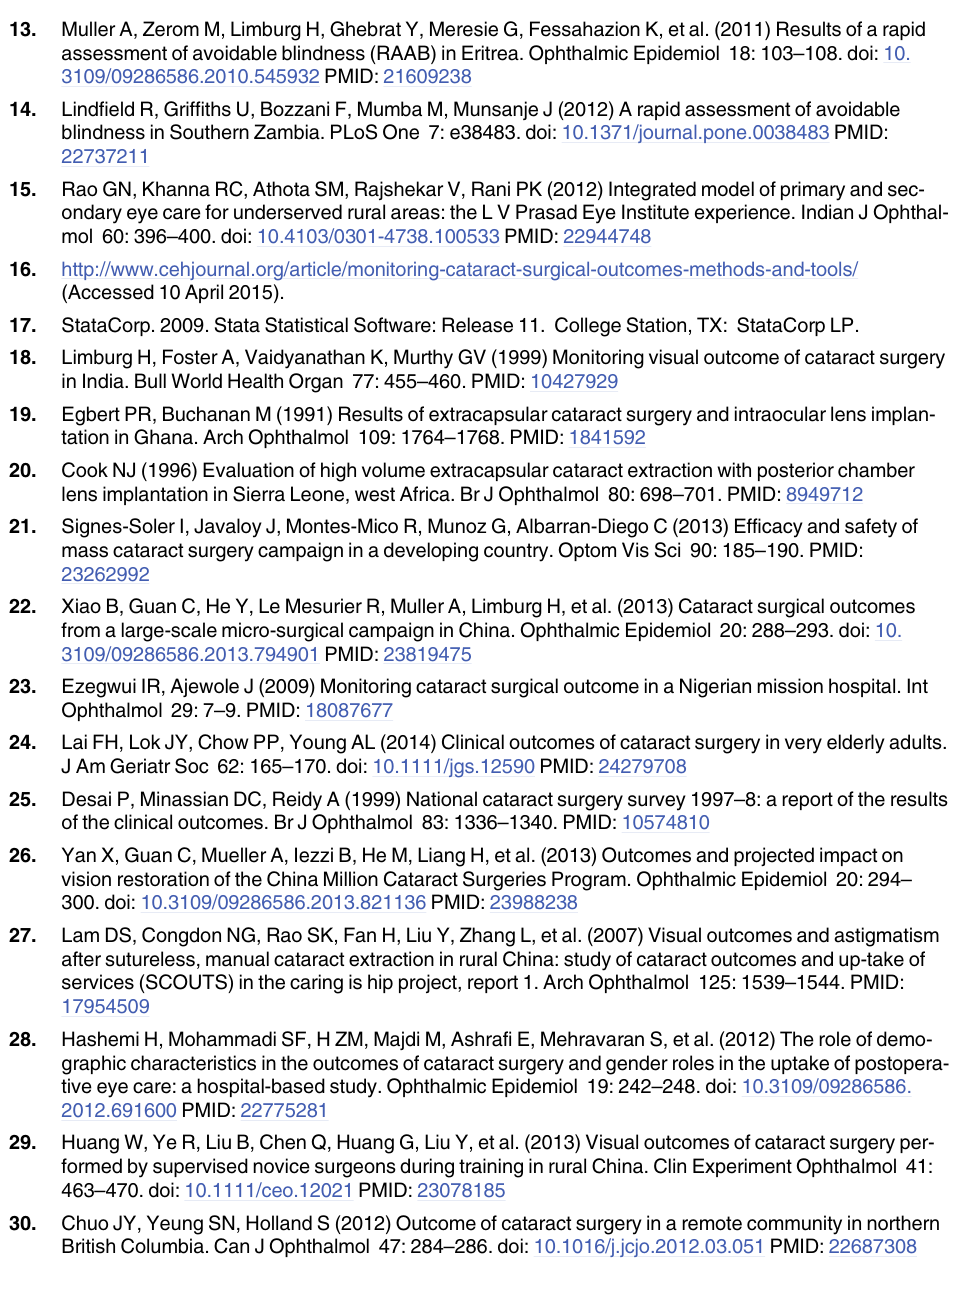
PLOS ONE | DOI:10.1371/journal.pone.0144853 January 7,